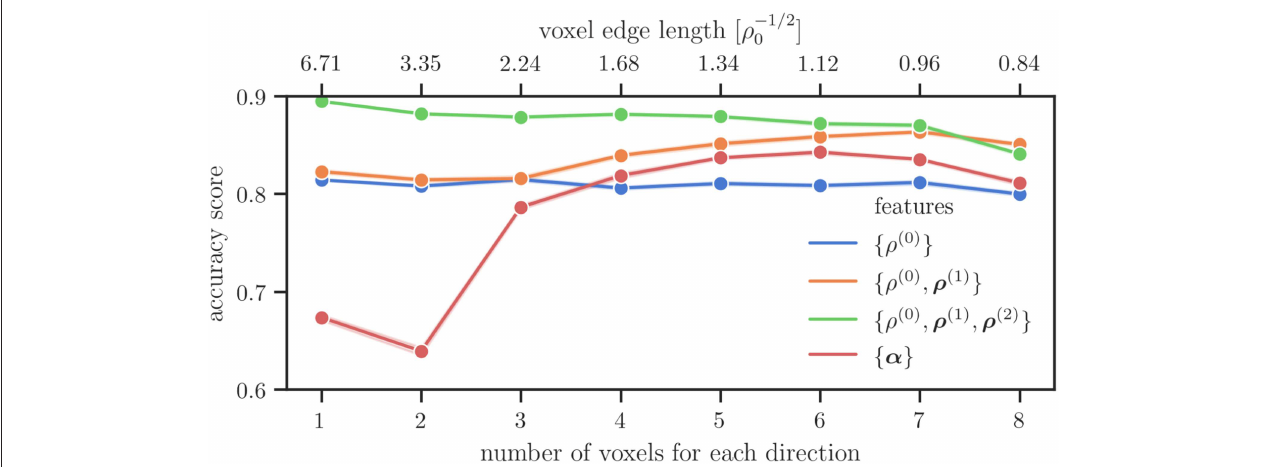
FIGURE 4 | Average accuracy score of the microstructure features in combinations that are used within their respective theories over the number of voxels along each axis used for the spatial discretization.